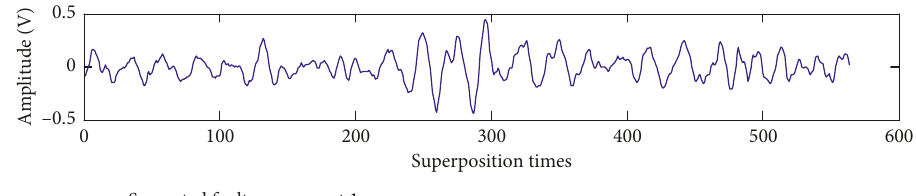
I 14 (cid:31) ( I 1 + I 3 + I 5 + I 7 + I 9 )